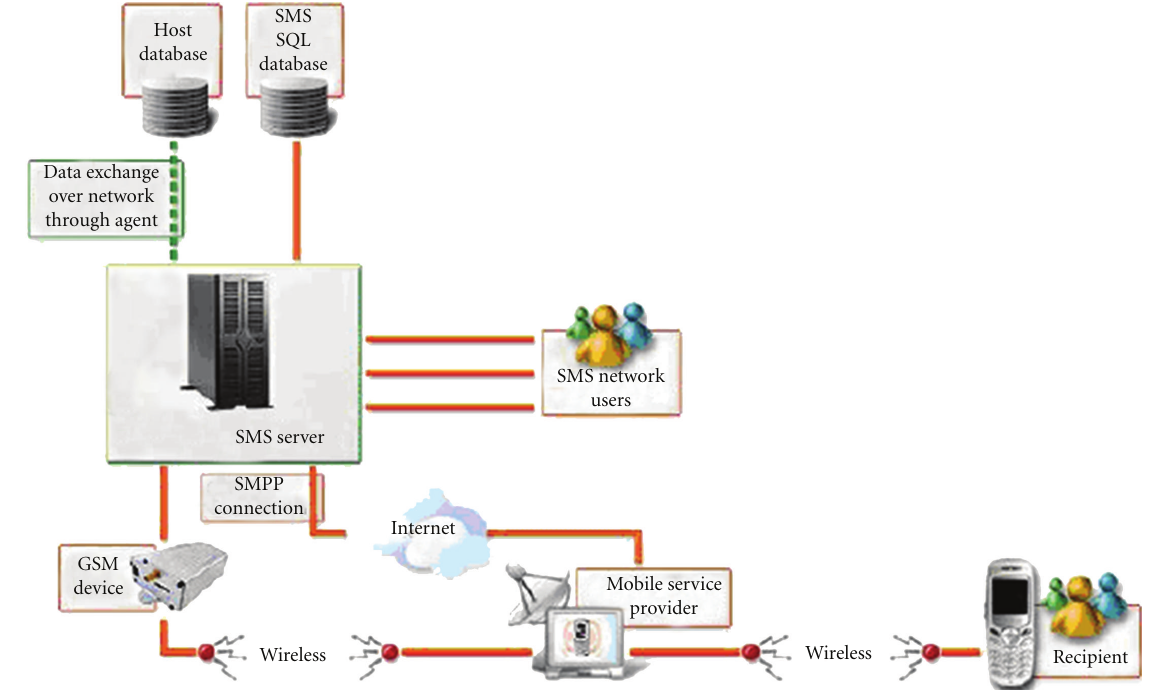
Figure 3: Delivery